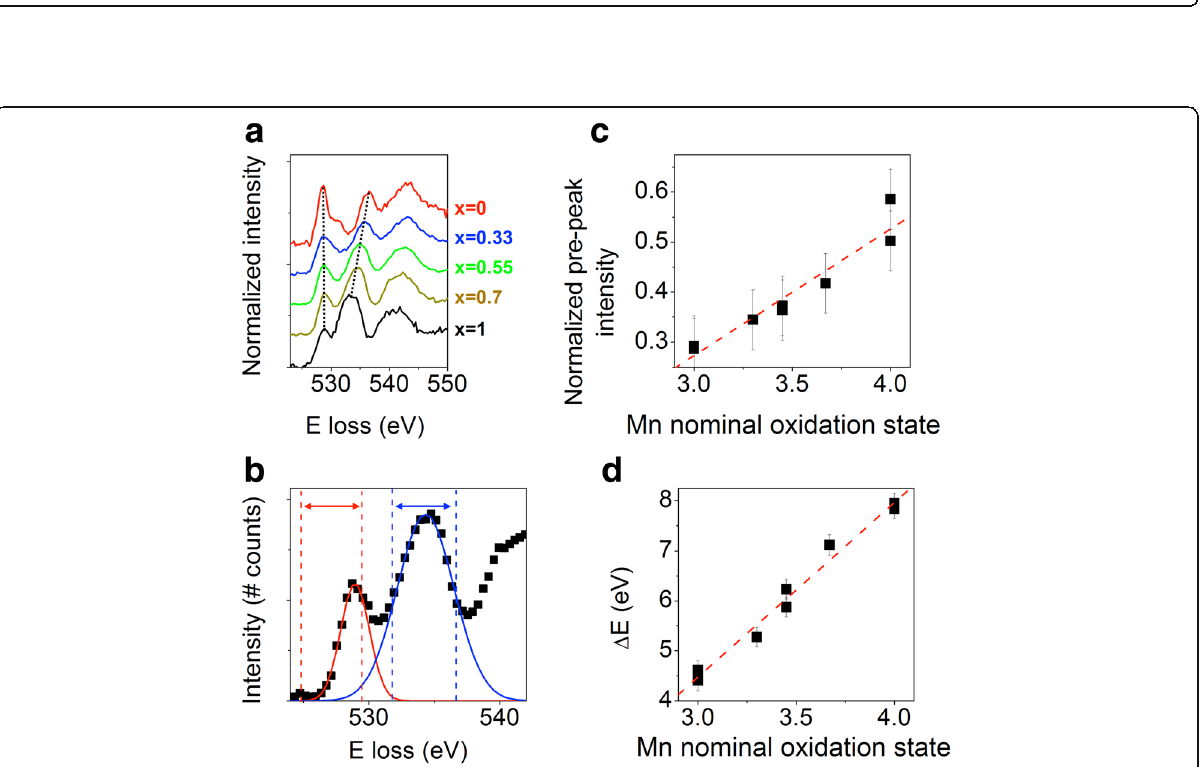
Fig. 12 a O K edges for a series of La x Ca 1- x MnO 3 compounds with x = 1, 0.7, 0.55, 0.33, and x = 0 from bottom to top. The energy scale has been shifted, so the pre-peaks are aligned, and the intensity normalized. The spectra have been displaced vertically for clarity. b O K EEL spectrum showing the Gaussian curves used to extract peak intensity and position (pre-peak in red and main peak in blue). c Normalized pre-peak intensity versus nominal oxidation state for the series of LCMO samples. The dashed line is a linear fit to the data. d Energy separation (calculated as the difference between positions of the second peak and the pre-peak) as a function of the Mn nominal oxidation state for the sample set of samples. Reprinted with permission from Varela et al. 2009. Copyright 2009 by the American Physical